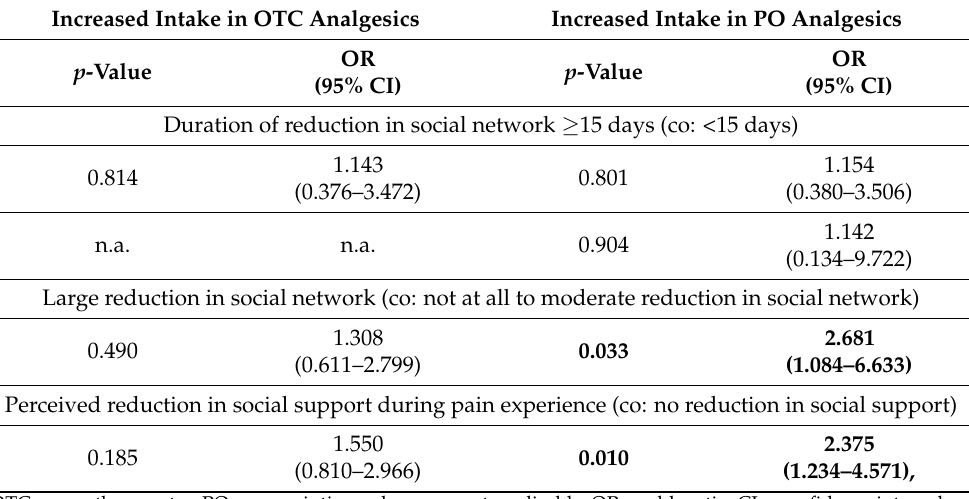
Table 1. Influence of pandemic-specific factors on changes in the intake of OTC and PO analgesics (univariate logistic regression